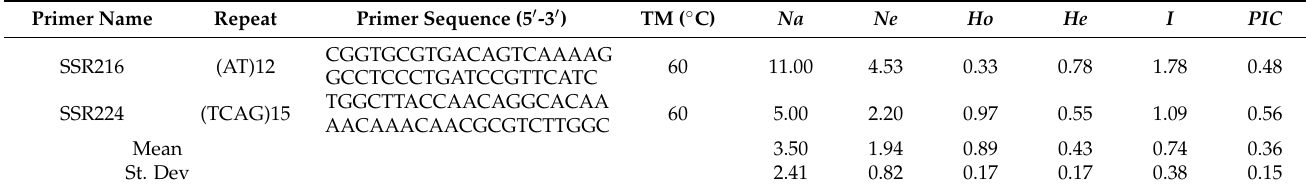
Figure 3. Principal component analysis based on 14 EST-SSR markers in E. indica . Coordinate 1 ex- plained 33.80% of the total variation and Coordinate 2 explained 15.53% of the total variation.